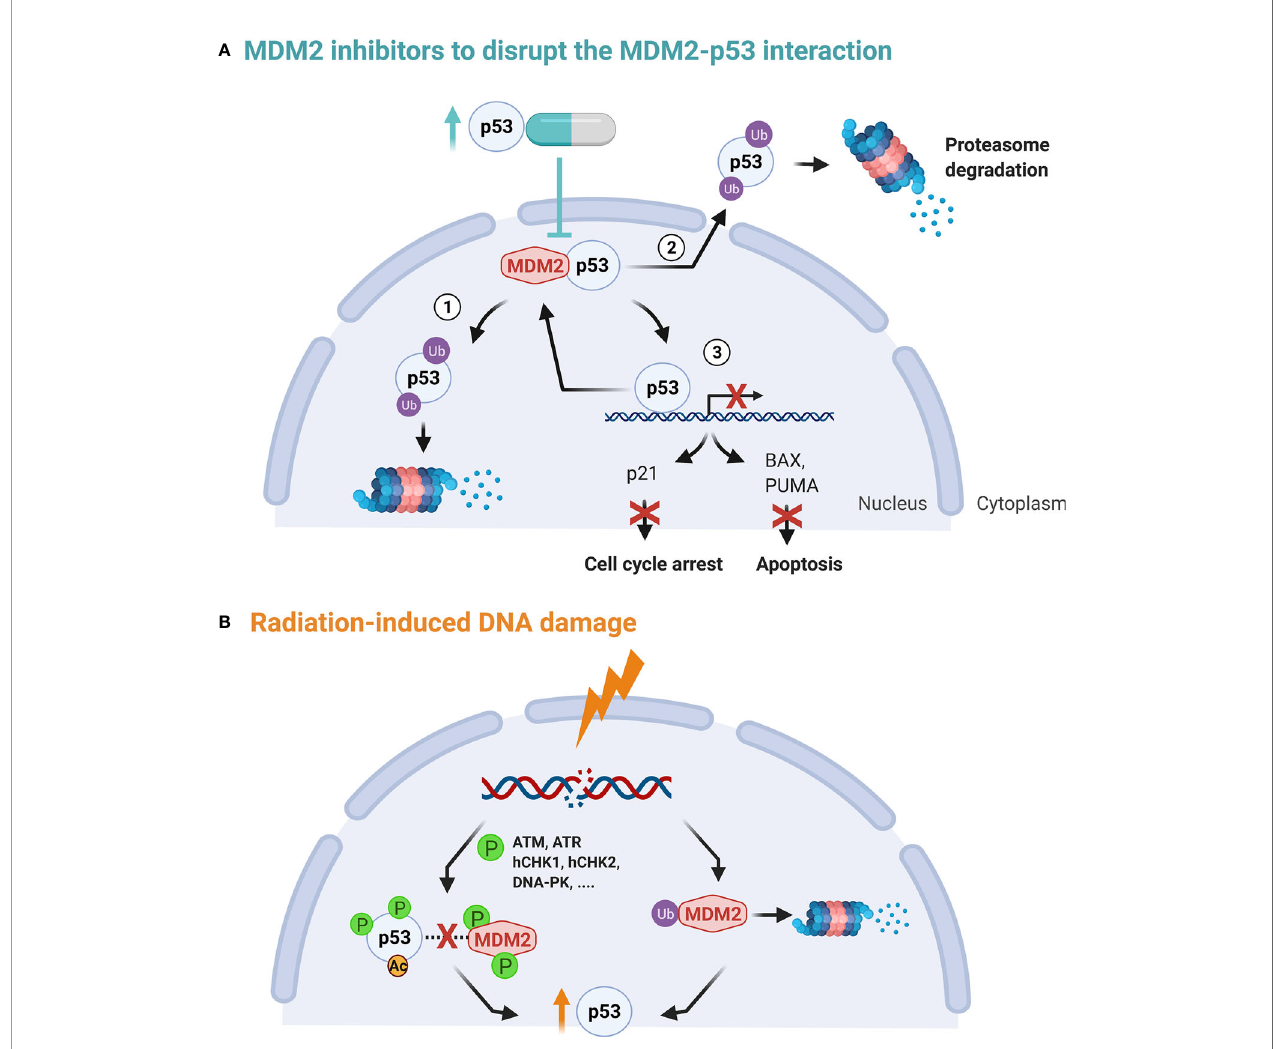
FIGURE 2 | (A) The p53-MDM2 autoregulatory feedback loop. p53 stimulates MDM2 expression while MDM2, in turn, inhibits p53 activity by stimulating its degradation in the nucleus and the cytoplasm (1, 2), promoting its nuclear export (2) and blocking its transcriptional activity (3) (72, 73). (B) Upon DNA damage, both MDM2 auto-degradation and phosphorylation of p53 is activated. This in turn disrupts the MDM2 binding, increasing transcription activation and stability of the p53 protein. In addition, ATM phosphorylation of MDM2 is critical for MDM2 destabilization, leading to less p53 ubiquitination (74,